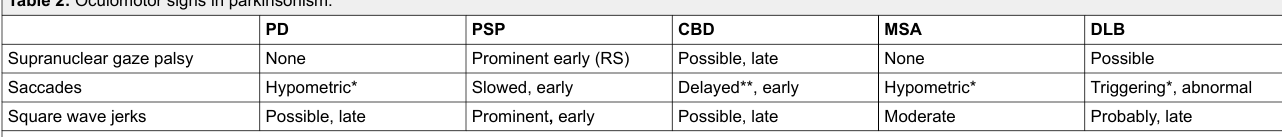
Table 2: Oculomotor signs in